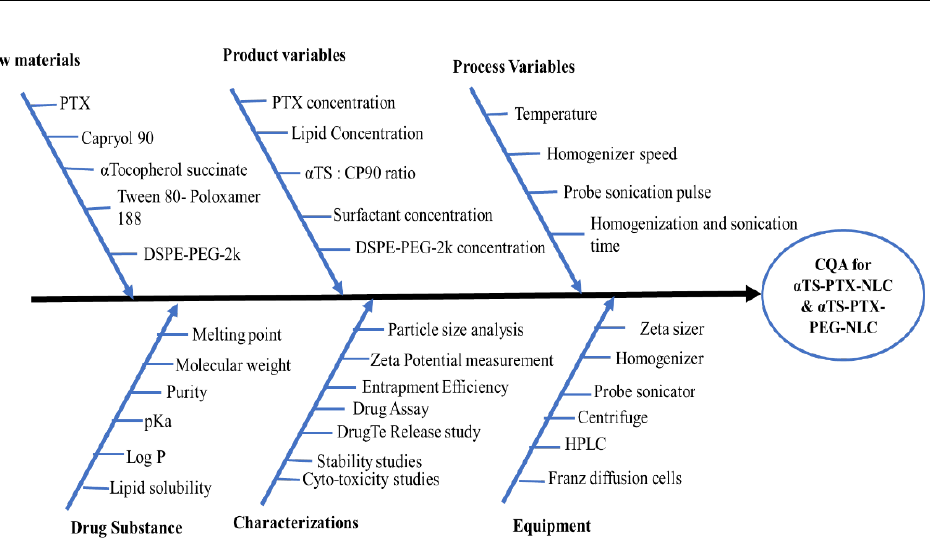
Figure 1. Ishiwaka diagram for the development of αTS -PTX- NLC and αTS -PTX-PEG-NLC formu-